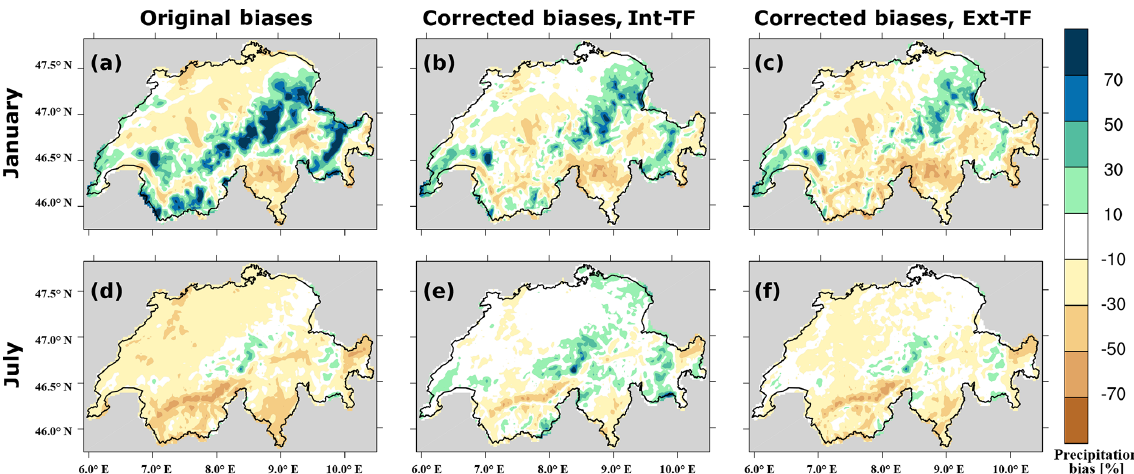
Figure 7. Biases in the climatological mean value of precipitation intensity over Switzerland. Panel (a) represents the original biases in January, (b) the biases after being corrected using Int-TFs in January, and (c) the biases after being corrected using Ext-TFs in January; panels (d) , (e) , and (f) are the same as (a) , (b) , and (c) but in July,